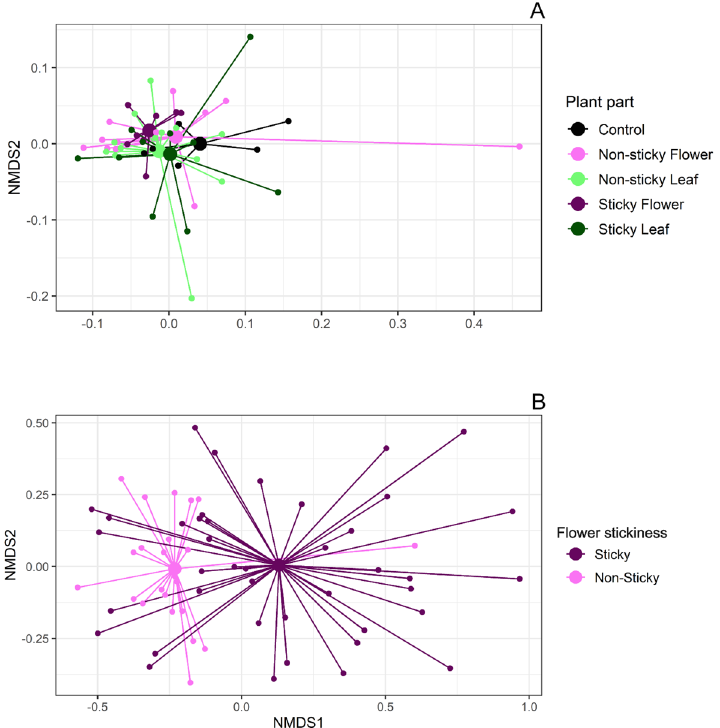
Figure 7. Non-metric multidimensional scaling for ( A ) volatile compounds from flowers and leaves and ( B ) non-volatile compounds from sticky and non-sticky flowers of Bejaria